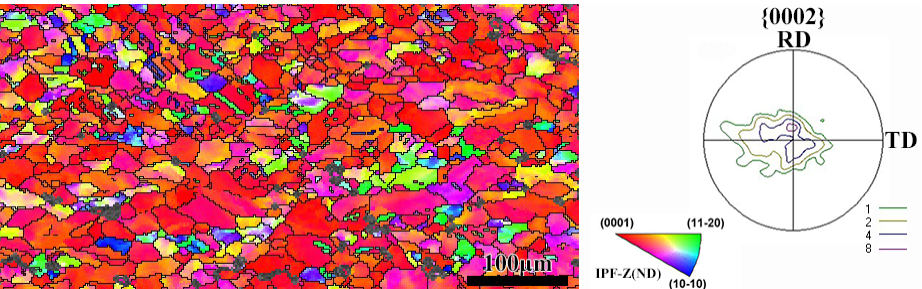
Figure 3. Orientation maps with IPF colors and pole figures of 600 °C rolled samples with 80% reduction.